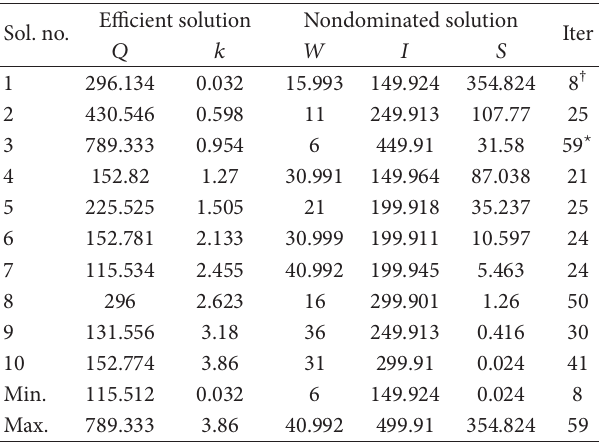
Table 4: Tradeoff solutions of Item 3 generated by successive